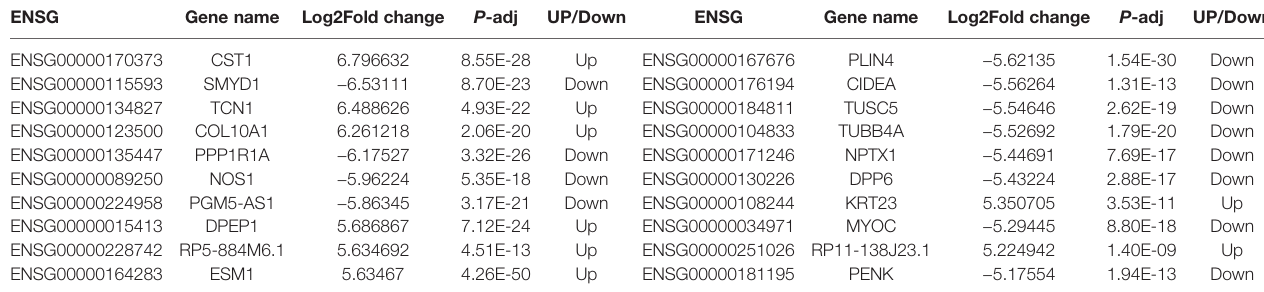
TABLE 1 | Top 20 differentially expressed genes between normal tissues and tumor tissues of patients with colorectal cancer (CRC). ENSG Gene name Log2Fold change